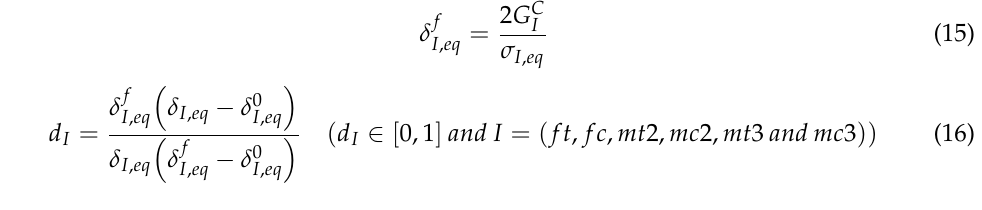
Table 3. Critical fracture toughness.